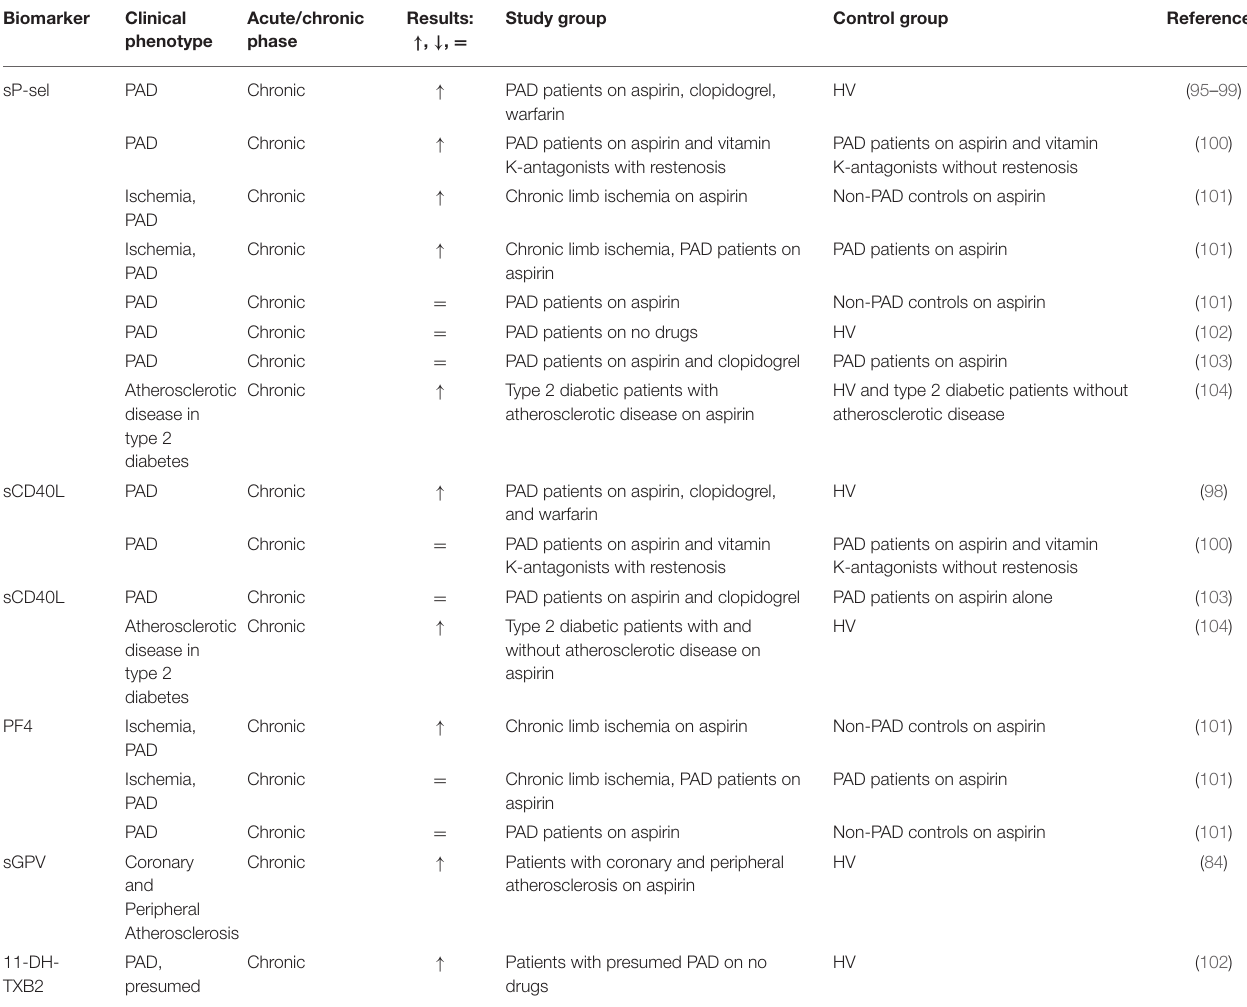
TABLE 2 | Soluble biomarkers of platelet activation in peripheral artery disease (PAD) and atherosclerotic